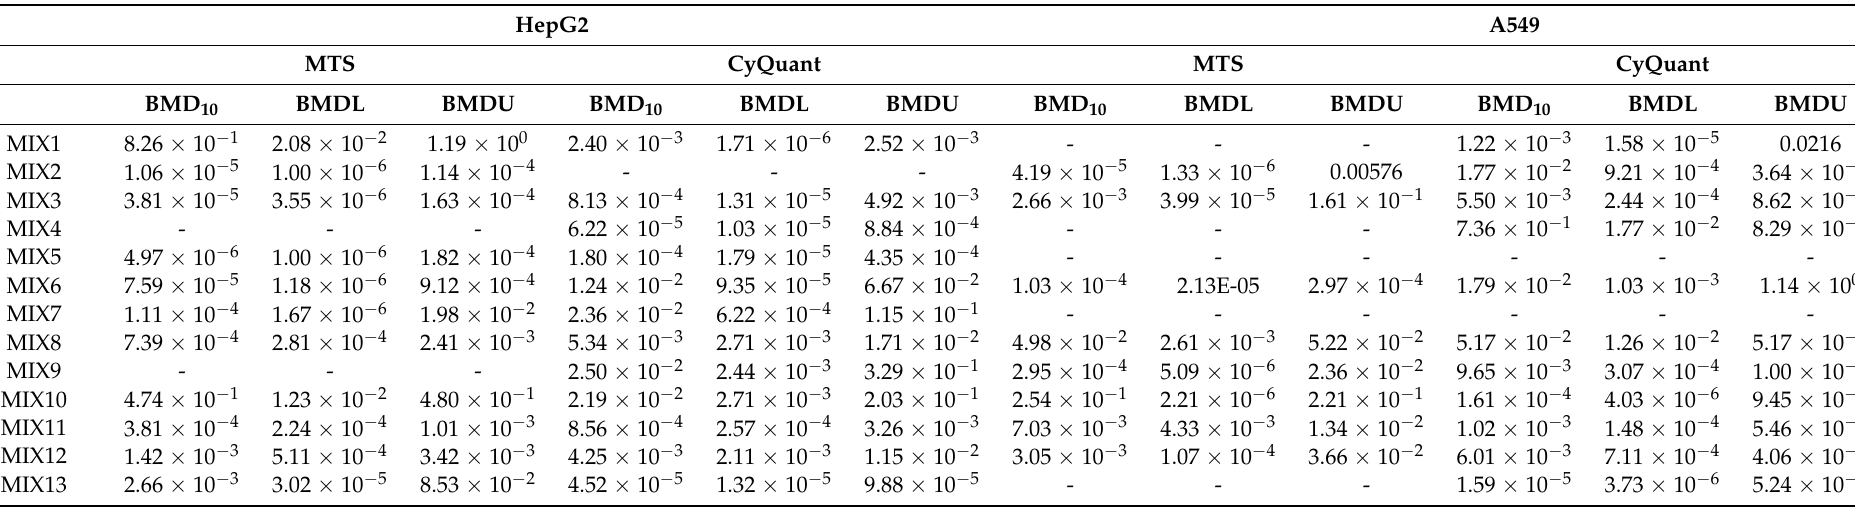
Table 3. BMD 10 values calculated for metabolic activity (MTS) and cell proliferation (CyQuant) assays in HepG2 and A549 cells with corresponding lower (BMDL) and upper (BMDU) bounds. Hyphens indicate that BMD 10 values could not be determined due to lack of convergence in the model